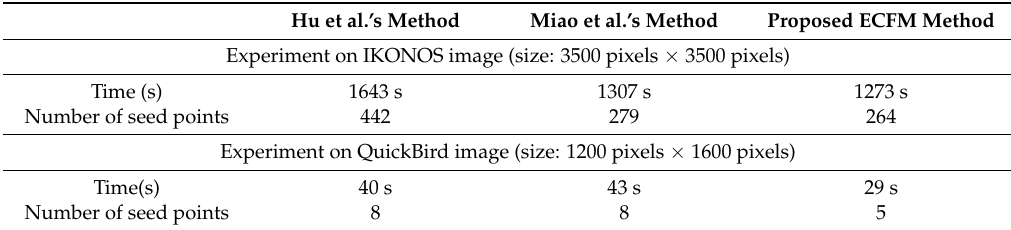
Table 4. Computation Cost of Different Centerline Extraction Methods.